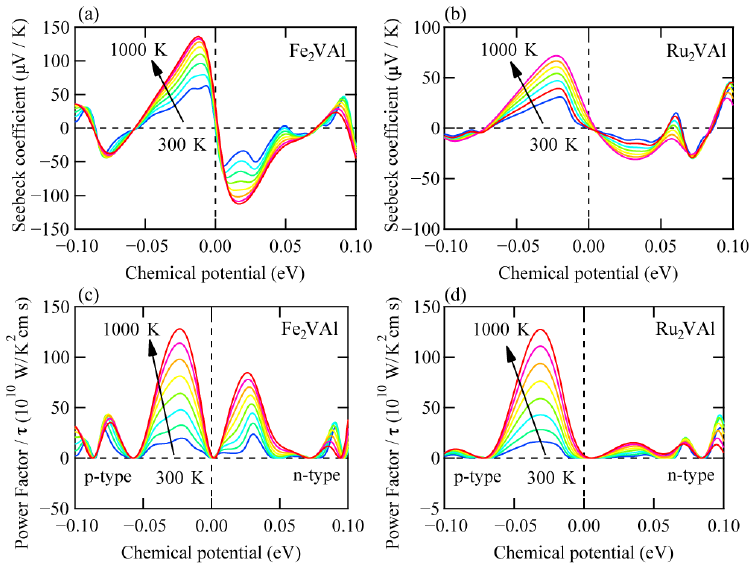
Figure 2. Chemical potential dependence of Seebeck coefficients and power factor for Fe 2 VAl ( a , c ) and Ru 2 VAl ( b , d ) calculated in the range of 300–1000 K.